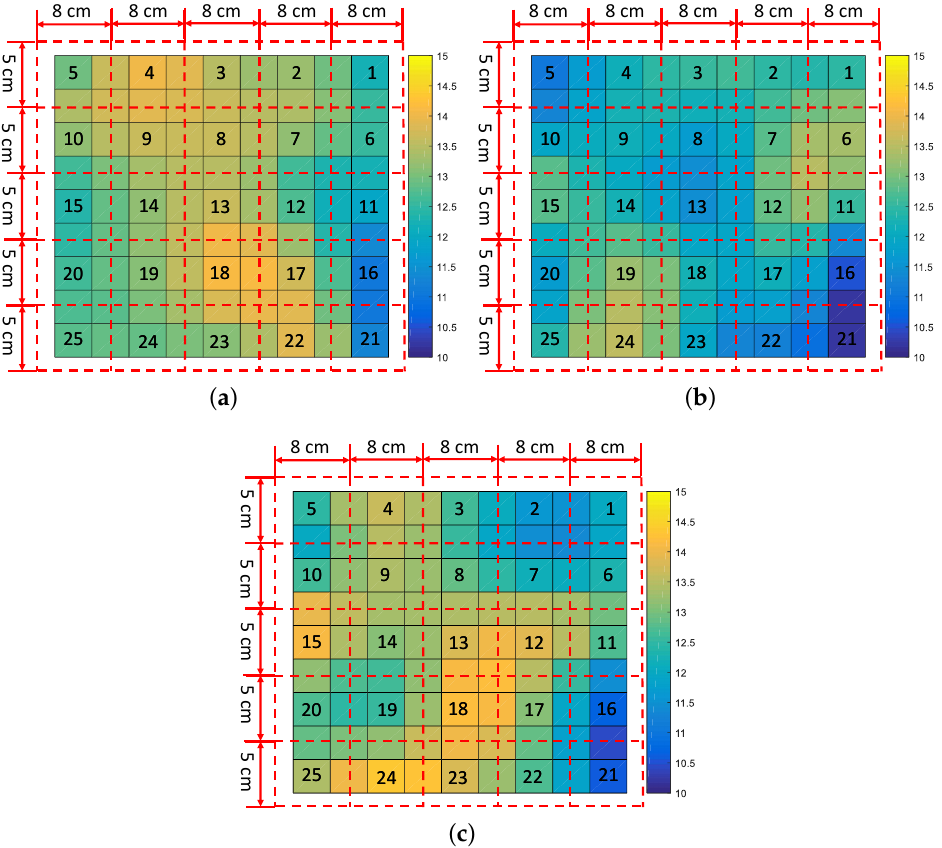
Figure 6. Noise reduction with the proposed active headrest with headtracking. Different colors indicate the amount of noise reduction: ( a ) noise reduction at left ear when the head has no rotation; ( b ) noise reduction at left ear when the head rotates leftwards 60 ◦ ; and ( c ) noise reduction at left ear when the head rotates rightwards 60 ◦